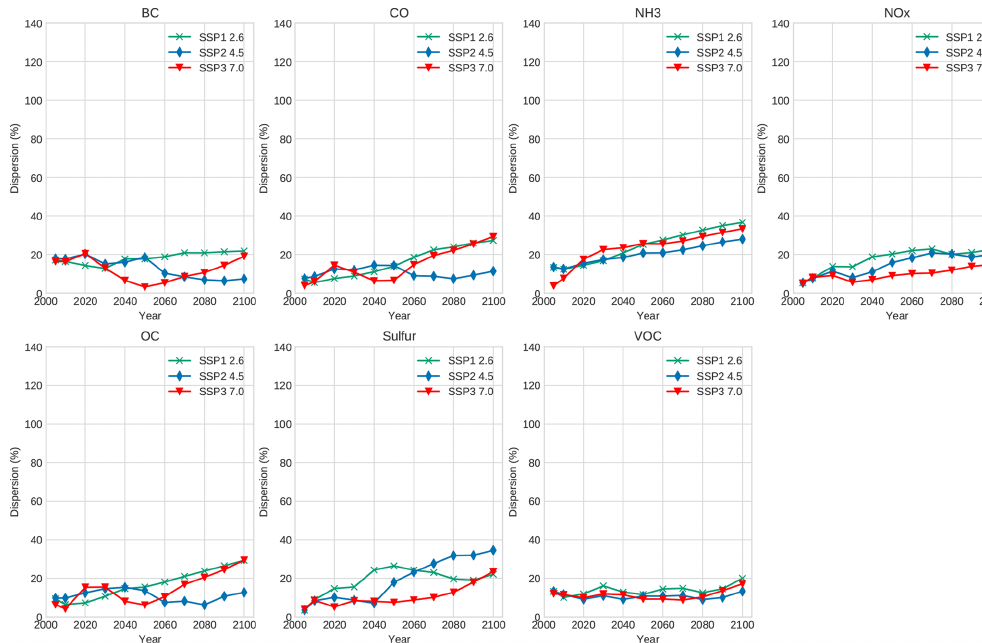
Figure H3. Dispersion analysis results for